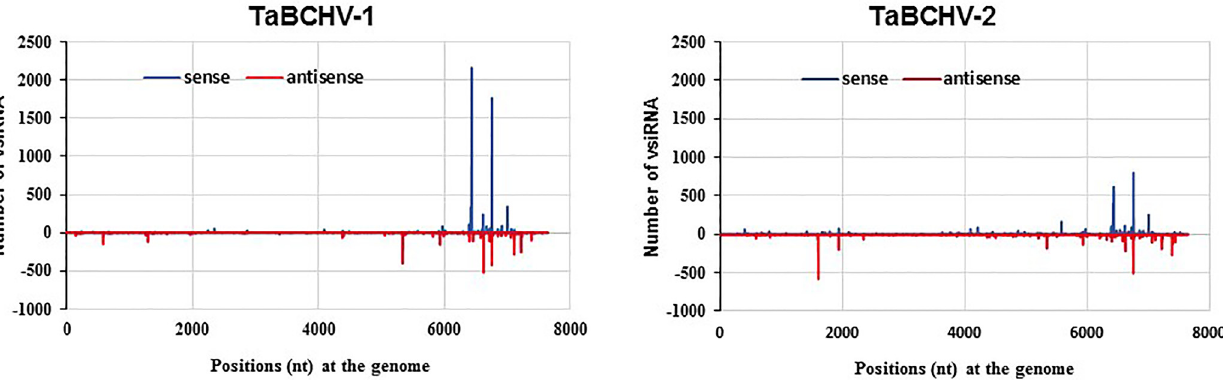
Fig 5. The distribution of 21- and 22-nt vsRNAs on the genomes of TaBCHV-1 and TaBCHV-2. The bars above the axis represent sense reads; those below represent antisense reads.